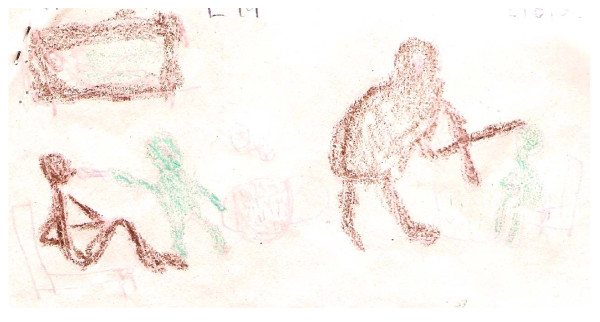
Drawing by Pascal.